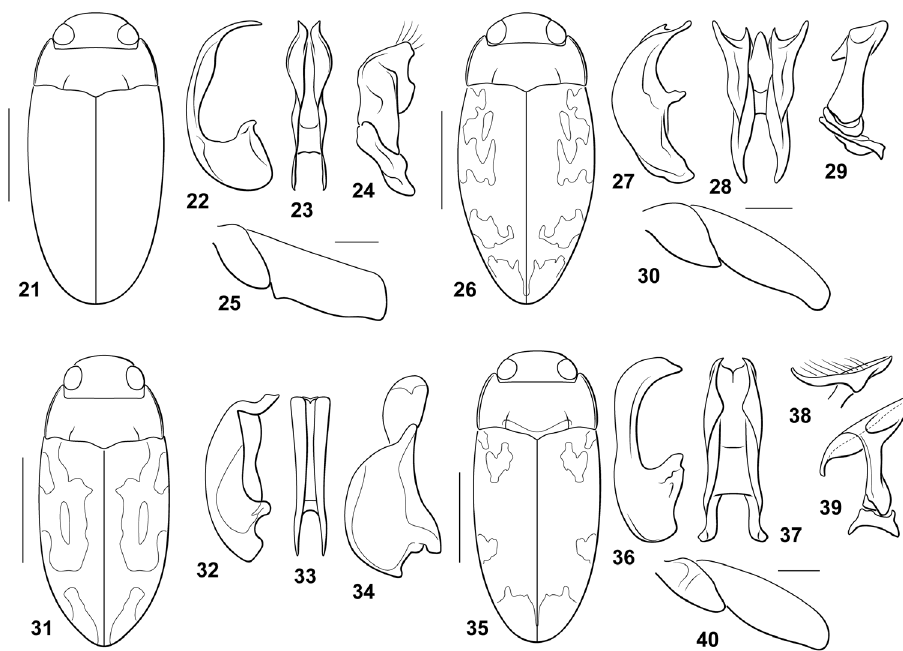
Figures 21–40. Bidessodes species. 21–25 B. acharistus 21 dorsal habitus, scale = 1 mm 22 male geni- talia 22 median lobe, right lateral aspect 23 median lobe, ventral aspect 24 right lateral lobe, right lateral aspect 25 left metatrochanter and metafemur, anterior aspect, scale = 0.25 mm 26–30 B. charaxinus 26 dorsal habitus, scale = 1 mm 27 male genitalia 27 median lobe, right lateral aspect 28 median lobe, ventral aspect 29 right lateral lobe, right lateral aspect 30 left metatrochanter and metafemur, anterior aspect, scale = 0.25 mm 31–34 B. demarcoi 31 dorsal habitus, scale = 1 mm 32 male genitalia 32 me- dian lobe, right lateral aspect 33 median lobe, ventral aspect 34 right lateral lobe, right lateral aspect 35–40 B. elongatus 35 dorsal habitus, scale = 1 mm 36 male genitalia 36 median lobe, right lateral aspect 37 median lobe, ventral aspect 38 apex of right lateral lobe, apical aspect 39 right lateral lobe, right lateral aspect 40 left metatrochanter and metafemur, anterior aspect, scale = 0.25